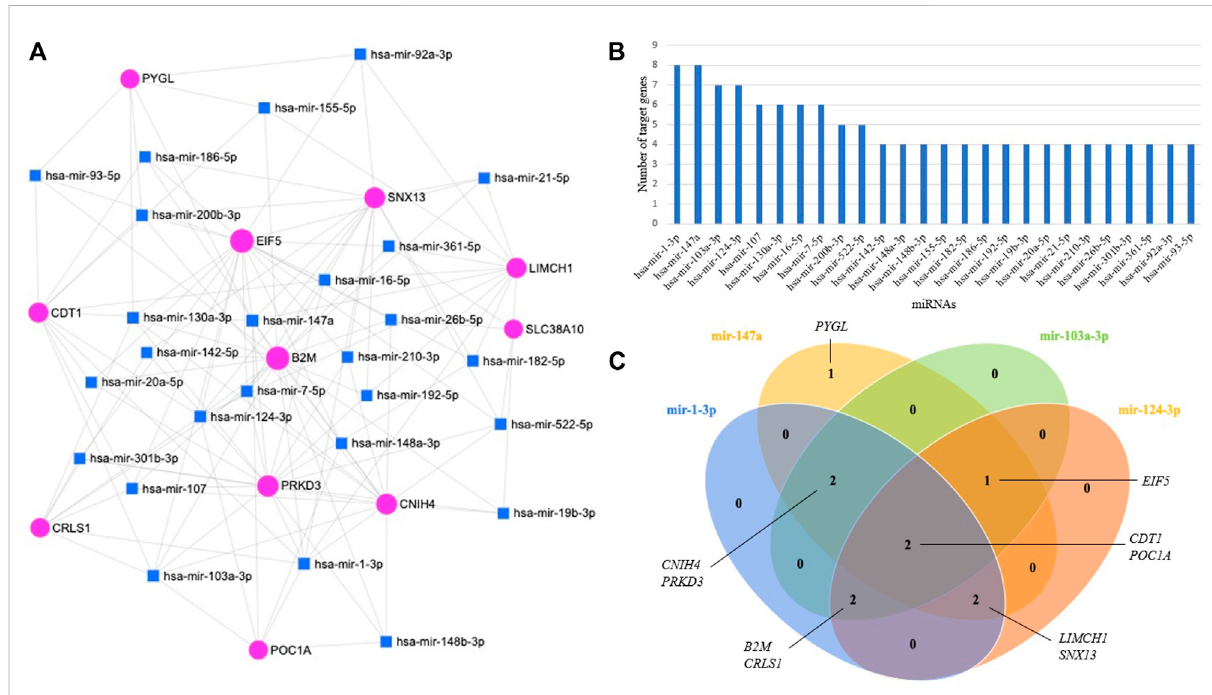
FIGURE 6 (A) miRNA-target gene regulatory network; the blue squares, and pink circles represent miRNAs, and genes, respectively. (B) Bar plot representing the distribution of miRNAs regulating genes with high diagnostic performance. (C) Venn diagram representing genes regulated by top four